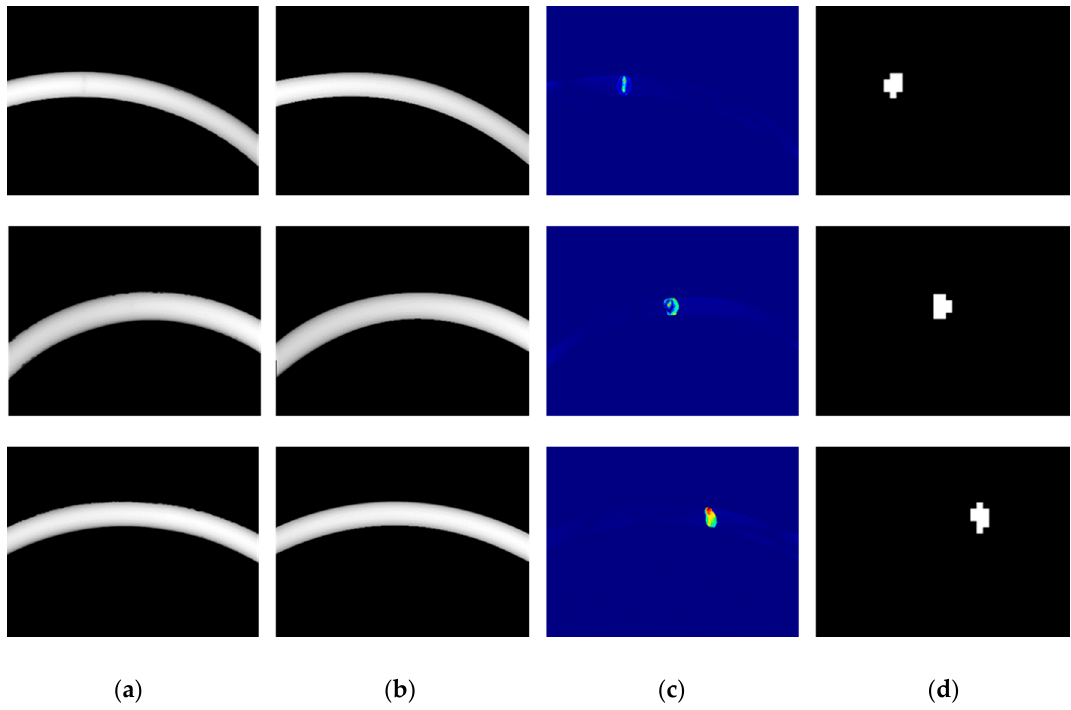
Figure 20. Defect detection processing with optical profilometer. ( a ) Model of optical profilometer reconstructed (Gray scale); ( b ) Smooth surface model M S (Gray scale), this model is the smooth version of ( a ), create by the method in this paper Section 2.2; ( c ) The deviation model M D , this model created by subtracting ( a , b ) (jet color map and mapped into range 0~500 μ m); ( d ) Candidate area (Binary images), which is produced by sliding windows with ( c ).